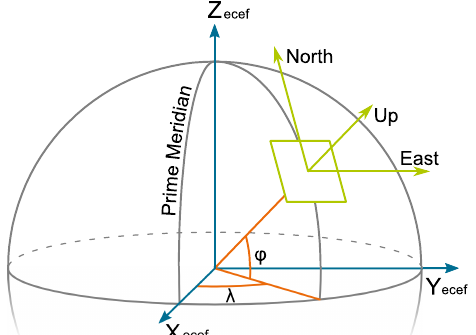
Figure 3: Both, the navigation systems of the INS and the world reference frame are based on Eeast, North, Up (ENU) coordinate systems (green). They are local Cartesian coordinate systems with the origin tangential to the earth ellipsoid. Further we use the global earth-centered, earth fixed (ECEF) coordinate system (blue), to convert between ENU-coordinates and GPS measure- ments taken in latitude ( ϕ ) and longitude ( λ ) as polar coordinates